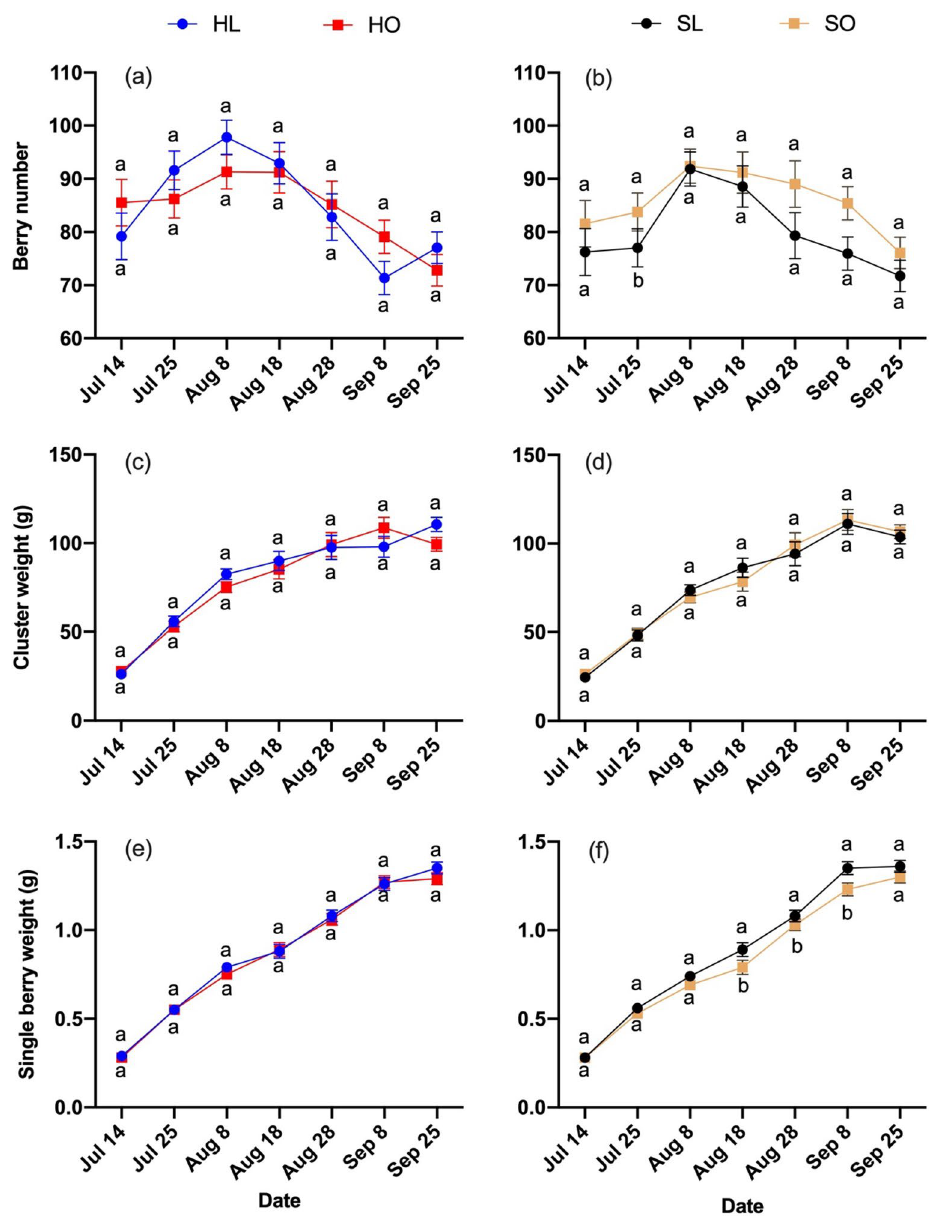
Figure 1. Berry weight traits in response to different treatments during the growing season in 2018 of ‘Riesling’. Berry weight traits: ( a , b ) Berry number, ( c , d ) Cluster weight, ( e , f ) Single berry weight. Treatments: (HL) Hedging with laterals, (HO) Hedging without laterals, (SL) Shoot wrap with laterals, (SO) Shoot wrap without laterals. Different lower-case letters showed significant differences at P ≤ 0.05